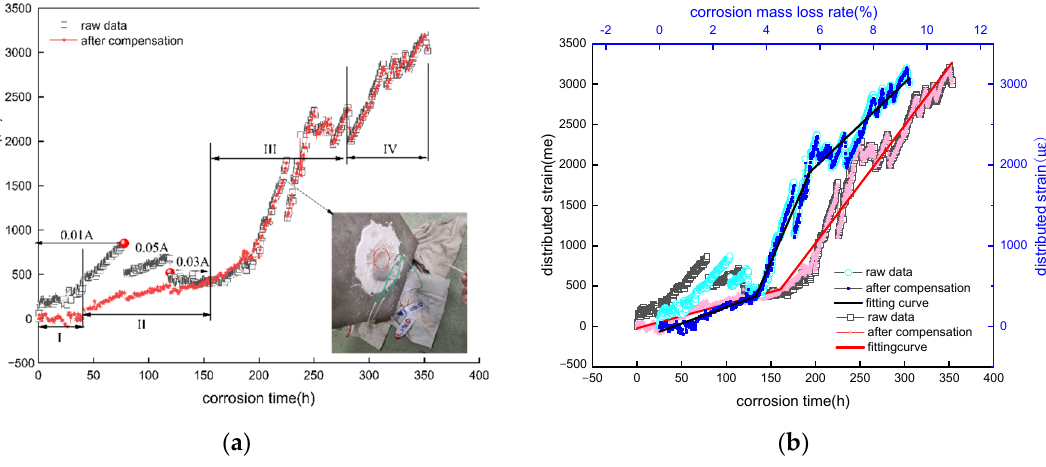
Figure 12. Fiber strain—time curve of reinforced layer of 2-300# specimen. ( a ) raw data from re-inforced layer distributed sensor; ( b ) fitting curve after temperature compensation.